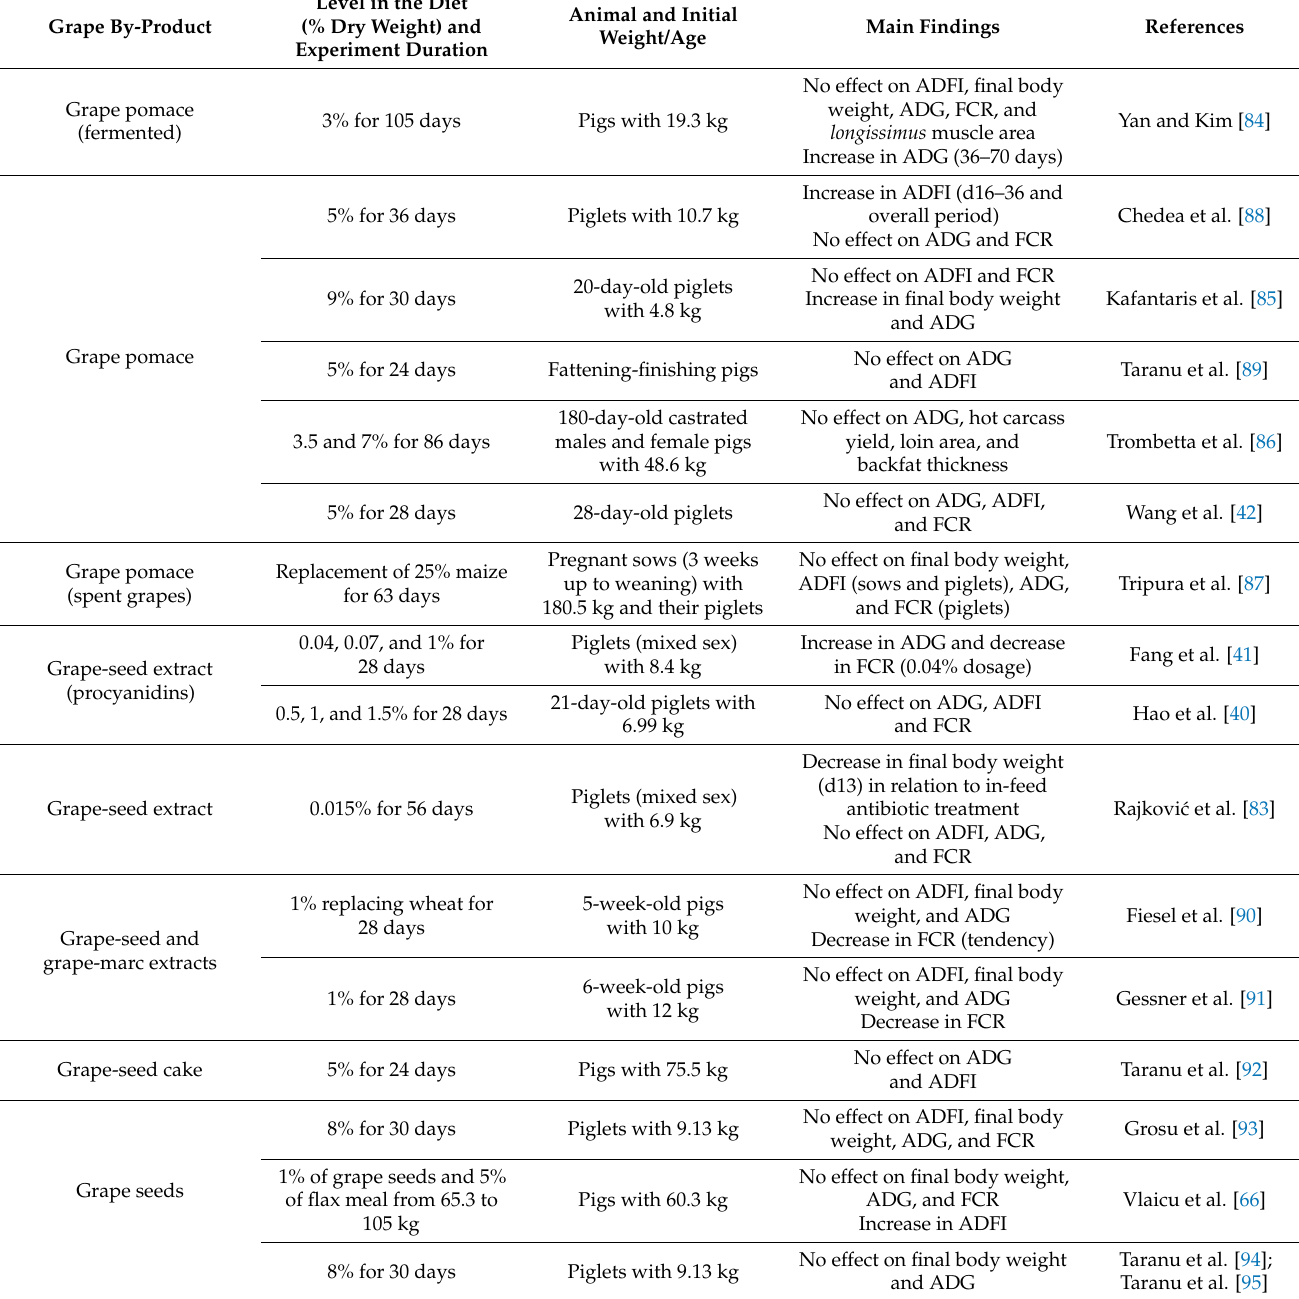
Table 3. Literature review on the effects of dietary inclusion of grape by-products on production performance of